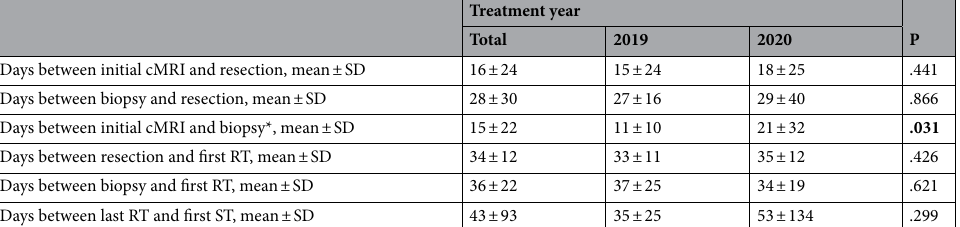
Table 6. Time expedited in days between treatment steps in comparison between the 2019 and 2020 cohorts. cMRI—cranial magnetic resonance imaging; RT—radiotherapy; ST—systemic treatment; SD—standard deviation; *initial biopsy rate 2019: 31.3%; 2020: 23.8%. Significant values are in